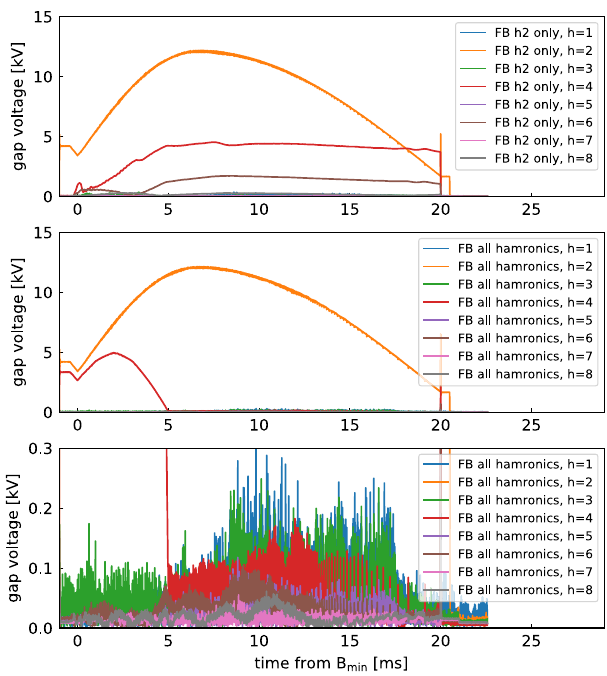
FIG. 33. Amplitudes of the harmonic components with an acceleration of a 1 MW equivalent beam from injection to extraction in the cases where (top) the feedback for the funda- mental acceleration harmonic ( h ¼ 2 ) is closed and the output of the others is turned off and (middle) the feedbacks for all harmonics are closed and (bottom) a vertically magnified view of the middle plot.